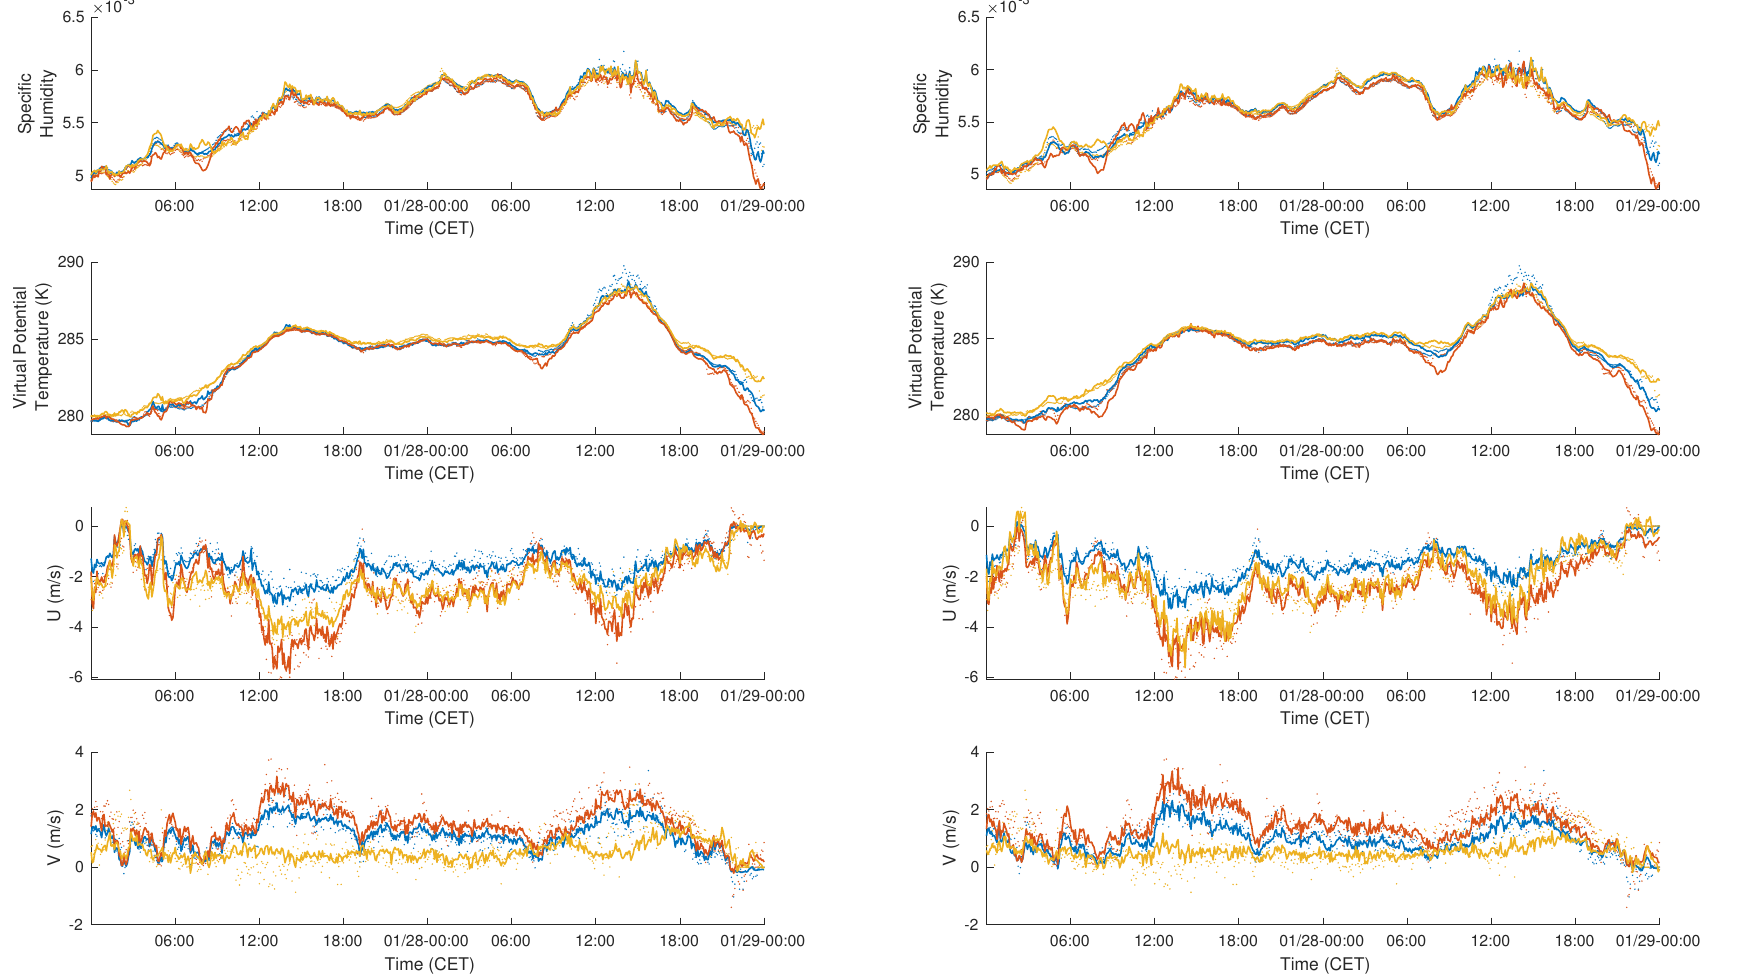
Figure 6. The same as Figure 5 but for 27 January 2017 to 29 January 2017 local standard time, representing a subset of the synoptically-forced flow